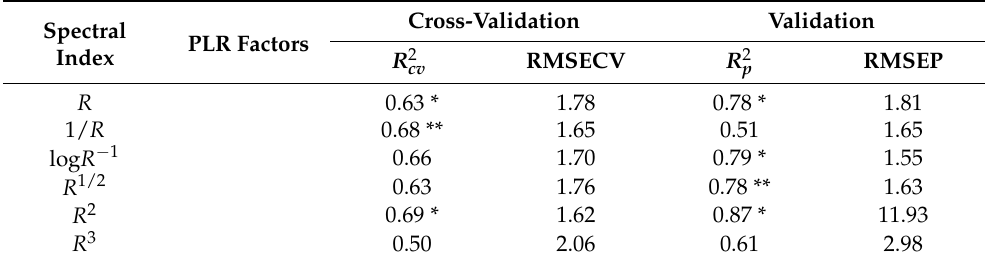
Table 8. Results of partial least squares regression analysis of the original spectral data and soil organic matter content.